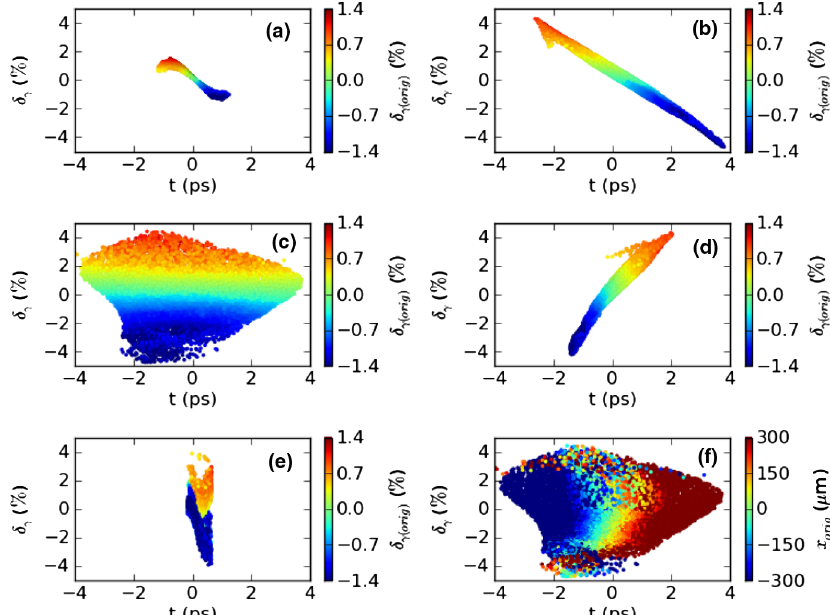
FIG. 7. Evolution of longitudinal phase space during the linac bunch compressor of case 1 in Table II. These longitudinal phase spaces are plotted for 90% of particles with 10% longitudinal tail cutoff (as explained in the footnote of Table I). These longitudinal phase space plots correspond to the locations at 110 cm for (a), 334 cm for (b), 414 cm for (c), 504 cm for (d), 675 cm for (e), and 414 cm for (f) of the linac bunch compressor as shown in Fig. 4 respectively. In plot (a) to plot (e), the particles are colored according to the energy spread at the focal point before the chicane (i.e., at 110 cm of the linac compressor shown in Fig. 4). In plot (f), the particles are colored according to the transverse horizontal position at the focal point before the chicane (i.e., at 110 cm of the linac compressor shown in Fig. 4). In these plots, particles located at t > 0 correspond to the tail particles of the